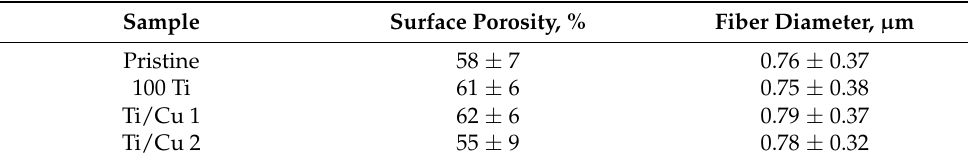
Table 2. Surface porosity and fiber diameter of plasma modified VDF-TeFE